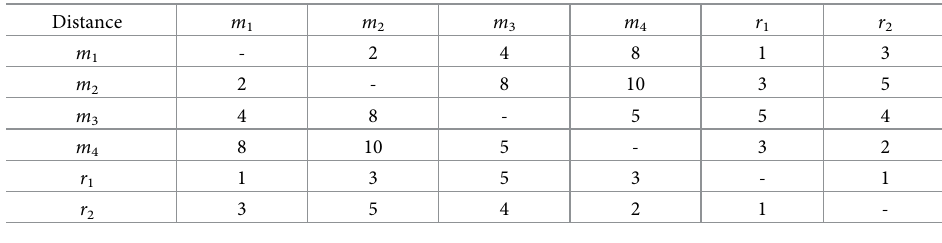
Table 3. The distance between order and store. Distance m 1 m 2 m 3 m 1 m 2 2 - 10 5 m 3 4